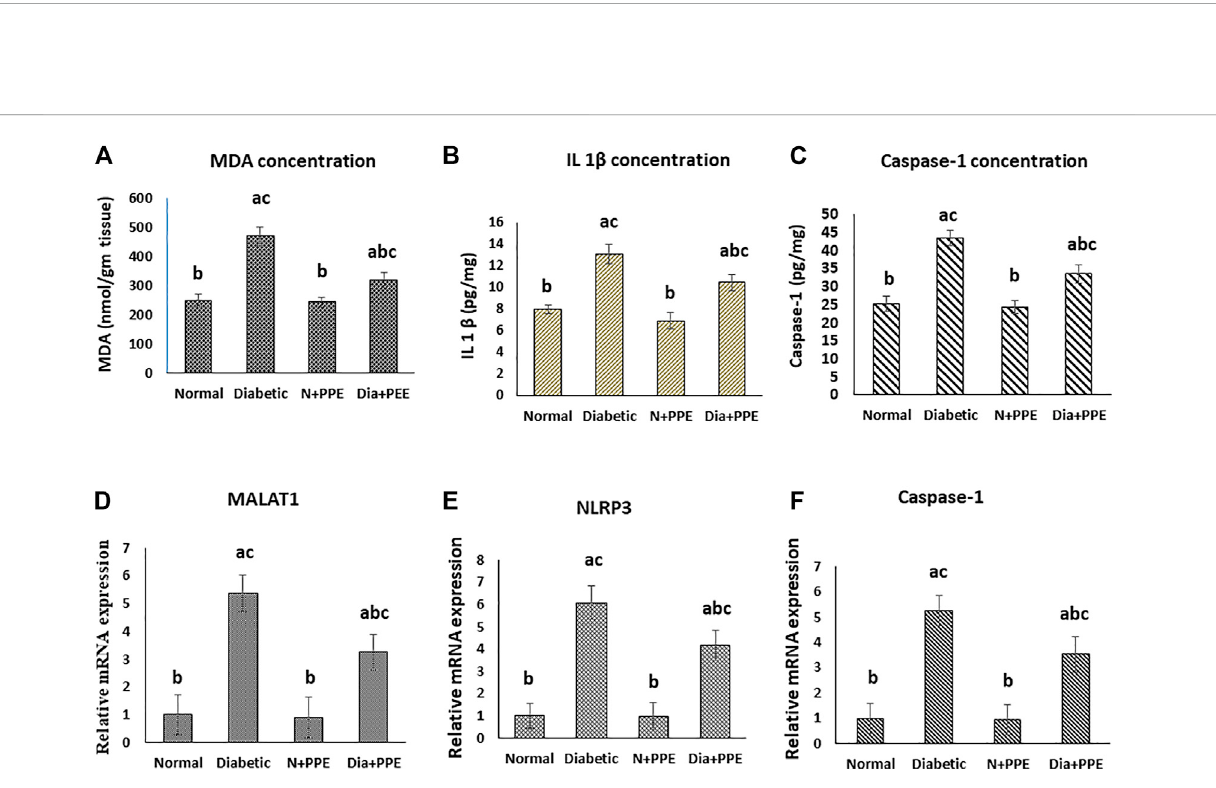
FIGURE 4 Effect of the pomegranate peel extract treatment on heart tissue of the studied rat groups. (A) : MDA level as marker of lipid peroxidation, (B) : IL-1 β content detected by ELISA. (C – E) : gene expression analysis of lncRNA-MALAT1, NLRP3, and caspase-1 respectively. The gene expression was measured